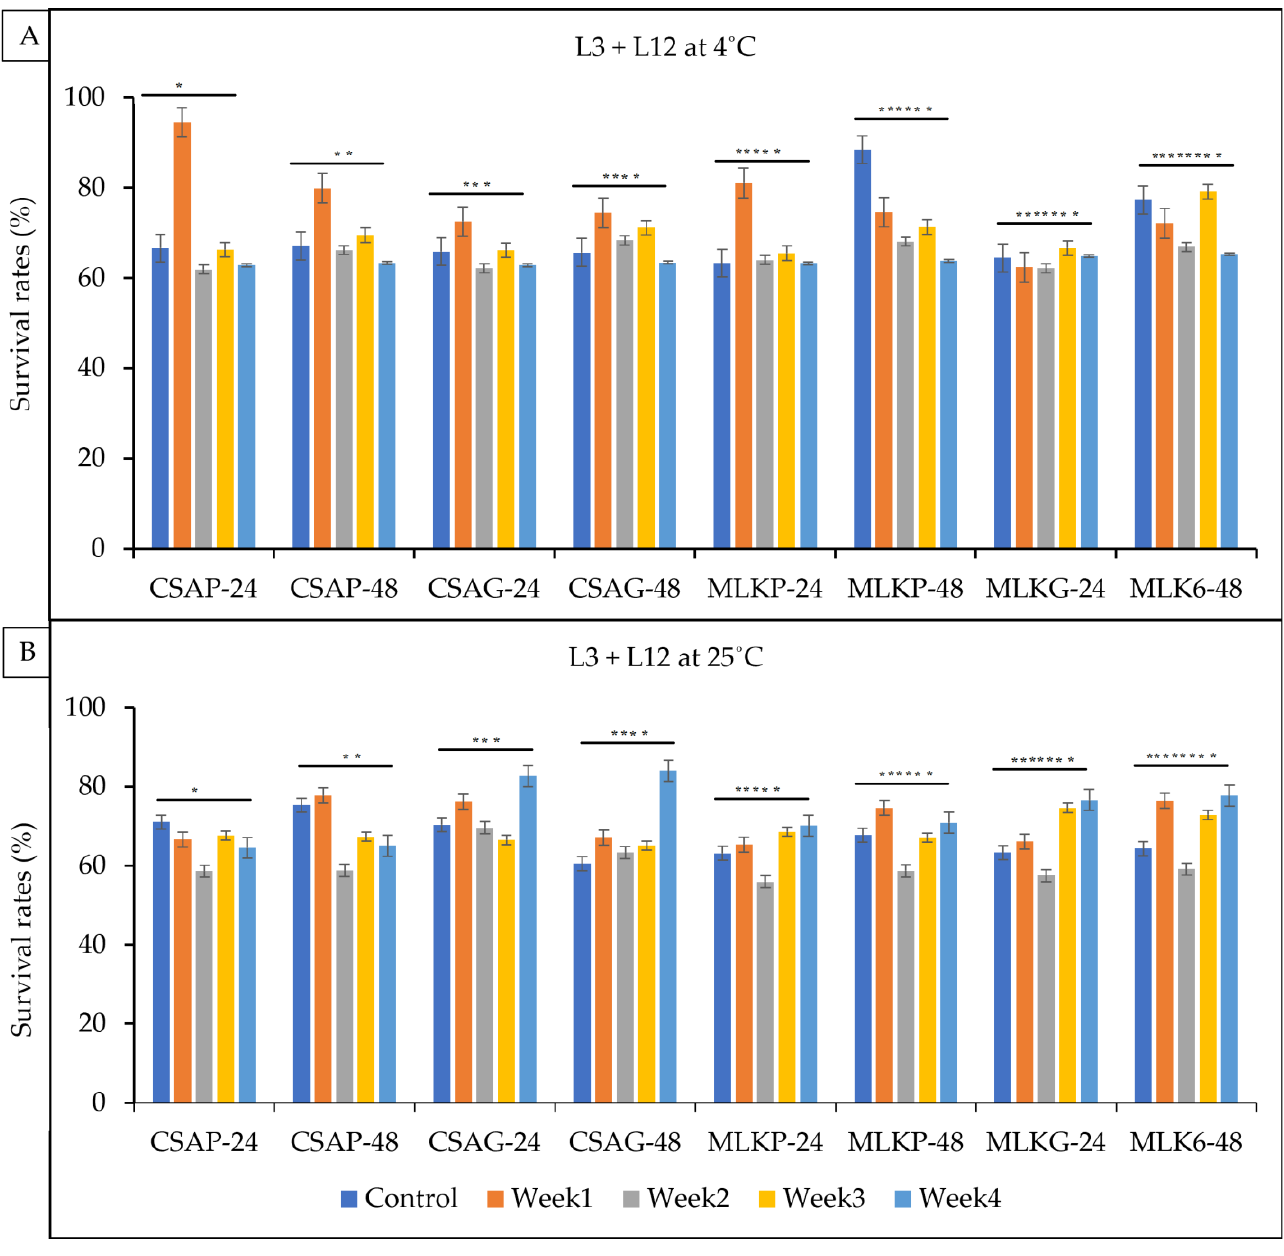
Figure 5. Viability of Lactococcus lactis (L3) + Lactobacillus delbrueckii (L12) following freeze-drying. ( A ) Survival rates at ambient temperature (25 ◦ C), and ( B ) survival rates at refrigerated temper- ature (4 ◦ C) for 24 h and 48 h. CSAP-24-Cassava in plastic at 24 h, CSAP-48-Cassava in plastic at 48 h, CSAG-24-Cassava in glass at 24 h, CSAG-48-Cassava in glass at 48 h, MLKp-24-Milk in plastic at 24 h, MLKP-48-Milk in plastic at 48 h, MLKG-24-Milk in glass at 24 h, MLKG-48- Milk in glass at 48 h. (Values represent means of three replicate experiments, ± : standard devia- tion). For ( A ) * p -value = 0.21514, ** p -value = 0.12357, *** p -value = 0.44616, **** p -value = 0.00959, ***** p -value = 0.03607, ****** p -value = 0.000000, ******* p -value = 0.314714, ******** p -value = 0.00102. For ( B ) * p -value = 0.000060, ** p -value = 0.00127, *** p -value = 0.06336, **** p -value = 0.00053, ***** p -value = 0.22466, ****** p -value = 0.40781, ******* p -value = 0.05309, ******** p -value =